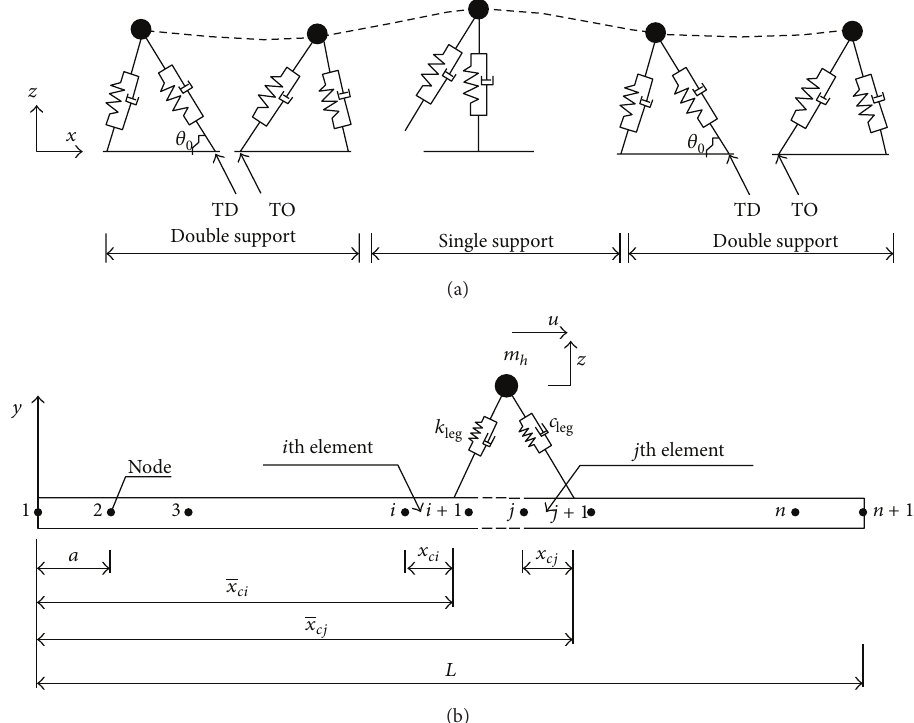
Figure 11: The schematics of Qin et al. (a) [54] and (b) [55] biomechanical walking model (TD: touchdown of leading leg; TO: toe off of the trailing